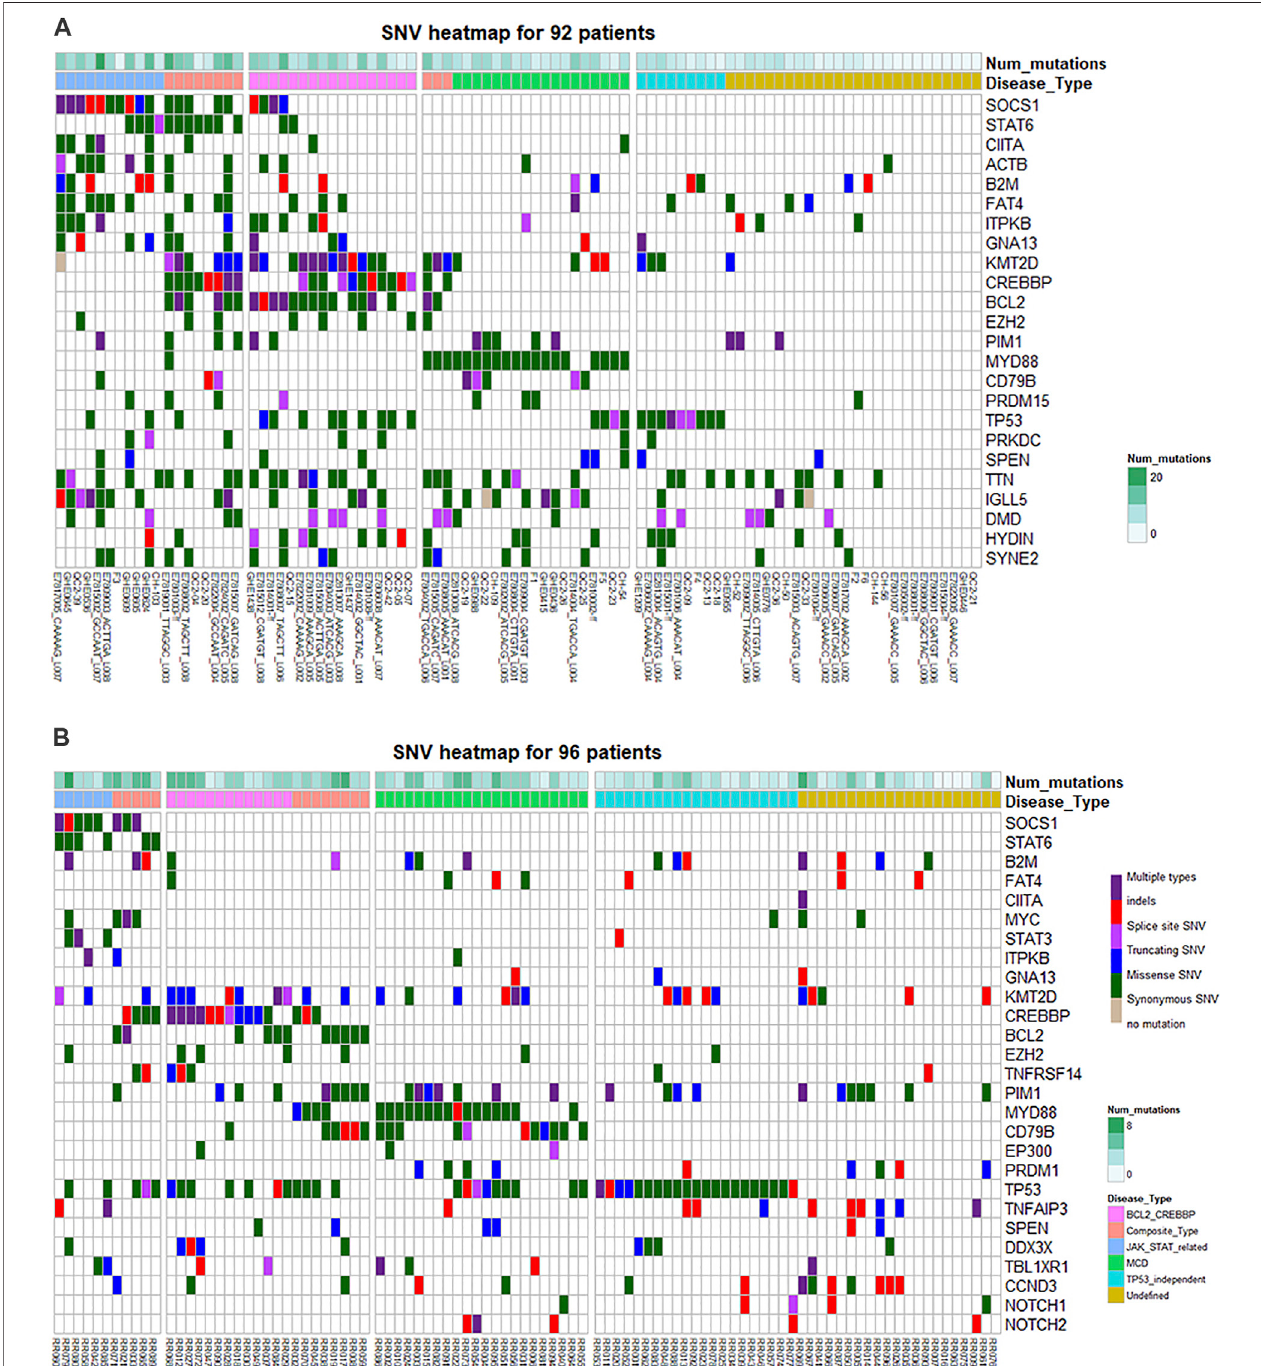
FIGURE 4 | Heat map of gene mutations of different subtypes. (A) Mutations of 92 patients in the cohort of public data. (B) Mutations of 96 RRDLBCL patients in the Chinese NGS cohort. “ Num mutations ” refers to the number of gene mutation types carried by a patient. TP53_independent TP53-independent type refers to TP53 mutant patients without genetic characteristics such as SOCS1-STAT6, BCL-CREBBP, and MYD88-CD79B.